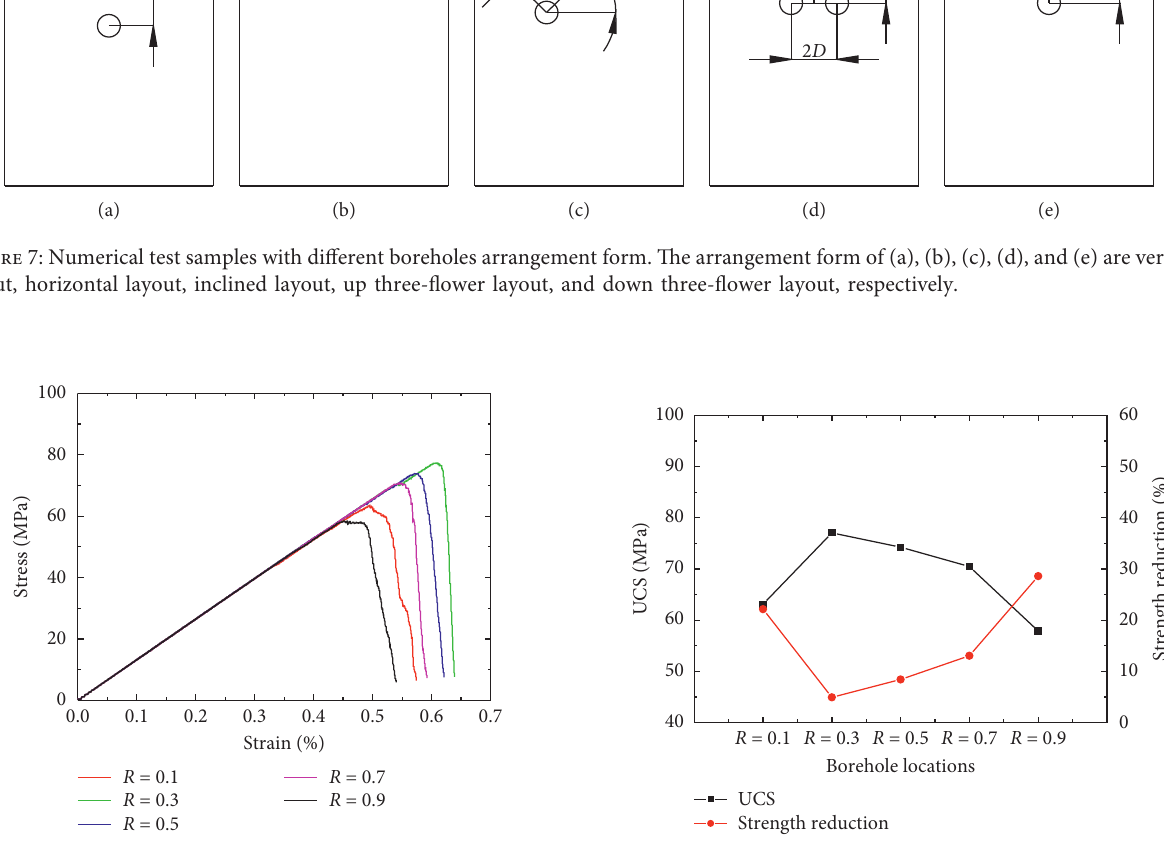
Figure 8: Stress-strain curves of rock samples with different drilling positions.